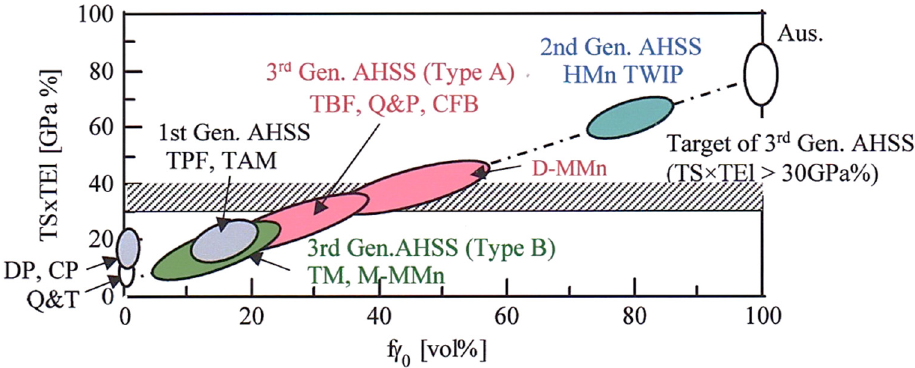
Figure 1. Relationship between the product of tensile strength and total elongation (TS×TEl) and initial volume fraction of austenite or retained austenite ( f γ 0 ) in the first-, second-, and third-generation (Type A and Type B) advanced high-strength steels (AHSSs). Q&T: conventional quenched and tempered martensitic steel, DP: ferrite–martensite dual-phase steel, CP: complex-phase steel, TPF, TAM, TBF, and TM: transformation-induced plasticity (TRIP)-aided steels with polygonal ferrite, annealed martensite, bainitic ferrite, and martensite matrix structure, respectively. Q&P: one-step and two-step quenched and partitioned steel, CFB: carbide-free bainitic steel, D-MMn: duplex-type medium Mn steel, M-MMn: martensite-type medium Mn steel, HMn TWIP: high manganese TWIP steel, Aus: austenitic steel. This figure is reproduced based on Ref. [52]. Reprinted with permission from Elsevier: Mater. Sci. Eng. A, Copyright 2021.